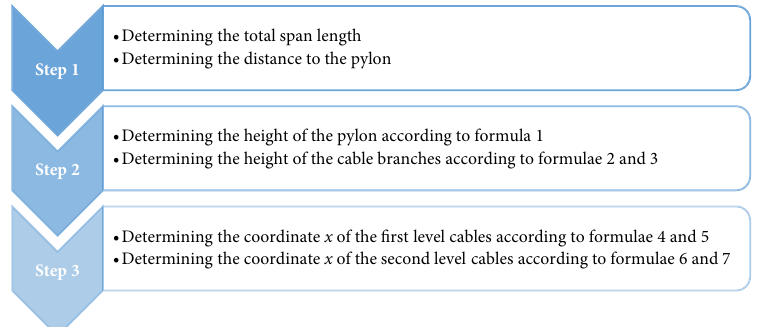
Figure 4. Algorithm for finding the coordinates of the cable connections of the branched cable-stayed